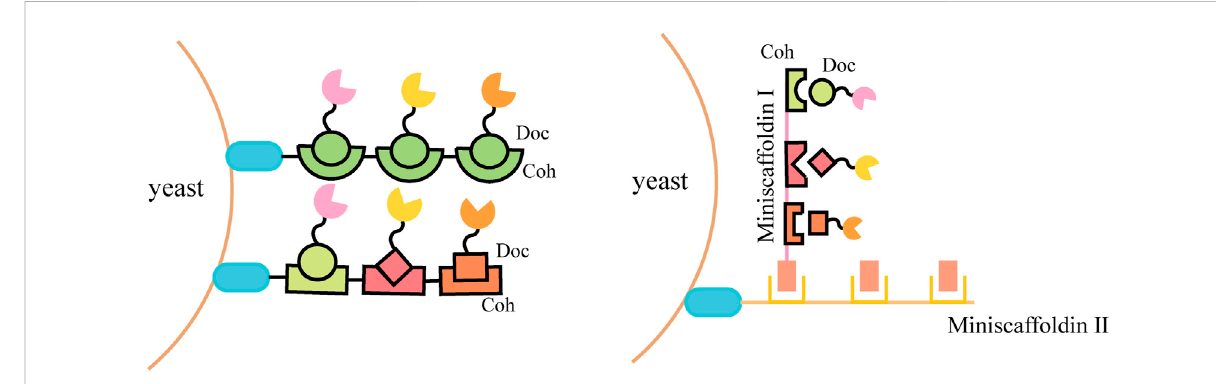
FIGURE 3 Schematic diagram of the assembly strategy on the yeast cell surface using